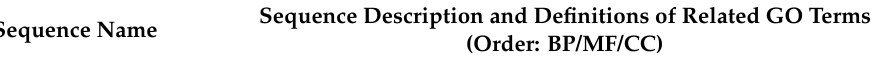
Figure 4. Outlier SNPs detected by three methods in comparison between populations of dwarf and Pyrenean pine. Three panels on the left represent outlier markers (significant at p / q value ≤ 0.05—blue and red points, the first values in brackets, or p / q value ≤ 0.01—red points only, the second values in brackets) revealed by FDist (207/43; top), BayeScan (14/8; middle) and FLK (178/28; bottom) methods. The right panel with a Venn diagram shows how the results from the less stringent level of significance in the three analyses overlap. From the output of the FDist method, only SNPs with Fst above 0.02 were considered significant and are colored. Table 3. Description of sequences containing the eight most credible outlier SNPs differentiating the two studied mountain pine